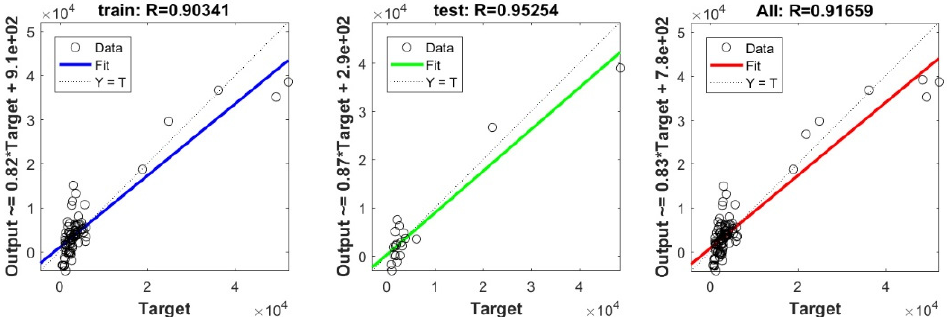
Figure A10. Scatter plots between target and output values by the STEP model.